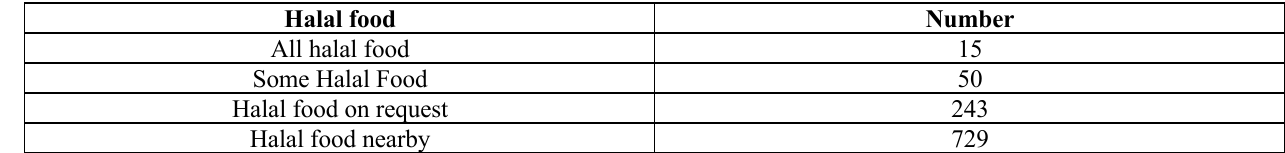
Table 2. Halal food services for hotels Source: Authors’ elaboration